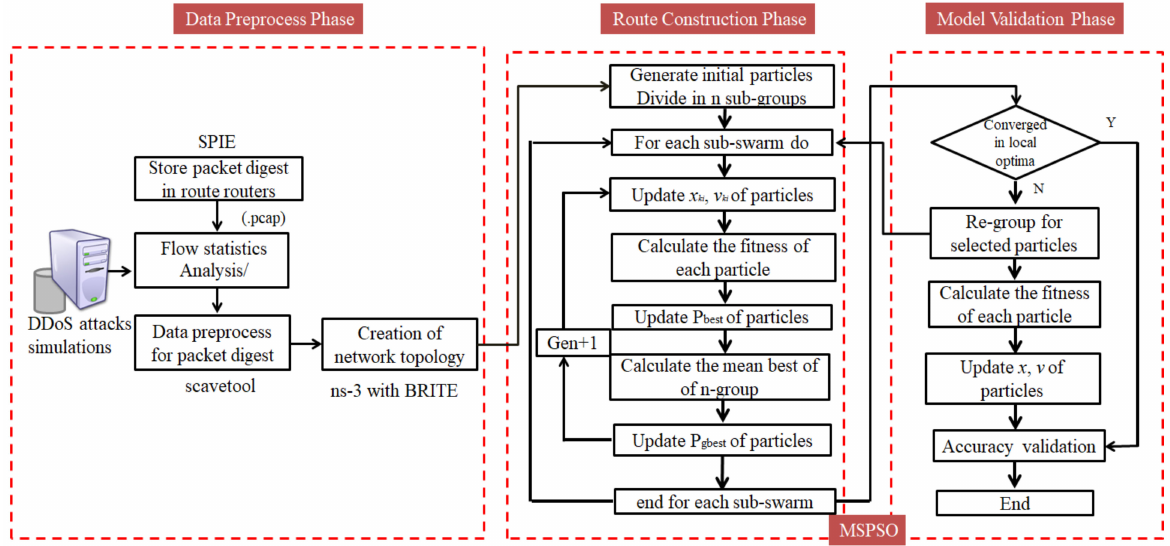
Figure 4. Basic concept of route construction with the revised PSO model.